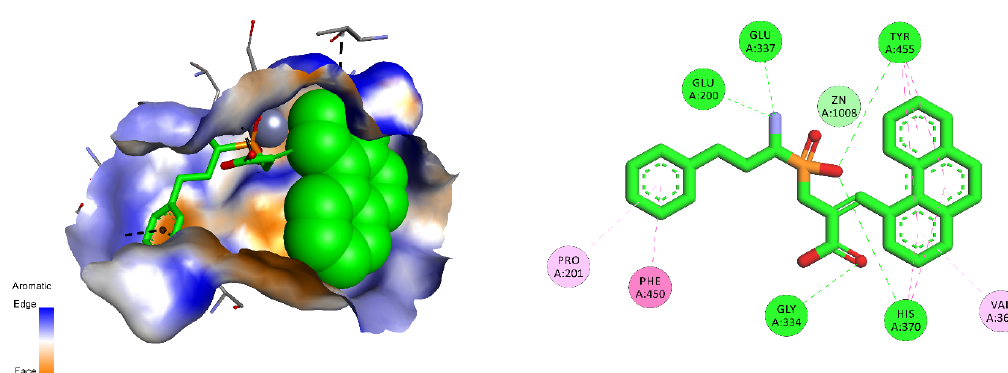
Figure 5. Modeled binding mode of a phosphinic dehydrodipeptide analog containing a phenanthren- 4-yl P1 (cid:48) fragment in the active center of ERAP2 aminopeptidase (PDB: 5AB0), with specified interactions as dashed lines: hydrogen bonds (green), π -alkyl (light pink), π – π stacking (dark